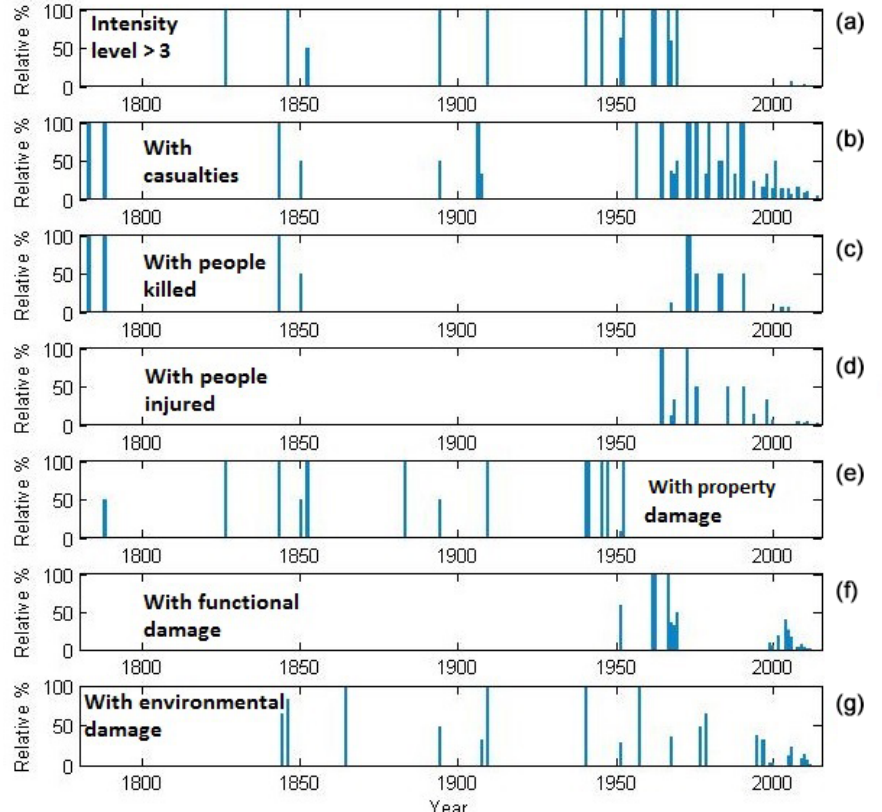
Figure 7. Relative chronology of the types of avalanches recorded. (a) Large avalanches with regards to all avalanches with a known size. (b–g) Avalanches that caused damage: deaths, injuries, property damage, functional damage and environmental damage, with regards to all avalanches. All percentages refer to avalanches for which the year is known with certainty (Table 3, third